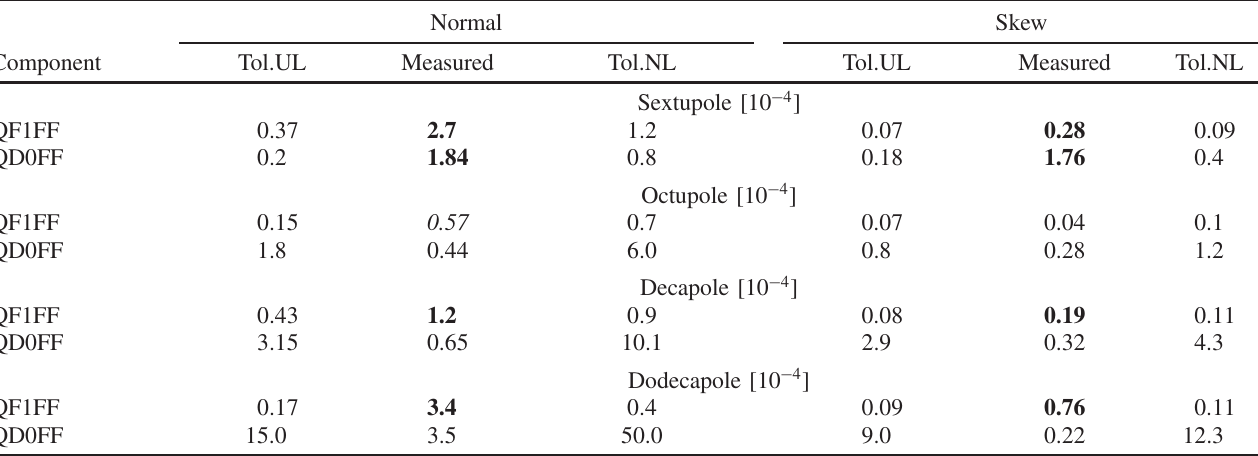
TABLE III. Comparison between the tolerances evaluated for the ATF2 nominal (Tol.NL) and ultralow β (cid:1) (Tol.UL) lattices and the measured multipole components of QF1FF and QD0FF at a radius (R) equal to 1 cm. Each tolerance represents a Δ σ (cid:1) y ¼ 2% . In bold letters the cases for which the measured multipole component does not meet the evaluated tolerances for both ATF2 lattices and in italic style when the measurements only meet the tolerance for the ATF2 nominal lattices.